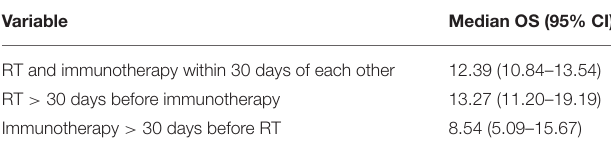
TABLE 5 | Median OS of RT and immunotherapy sequence groups.